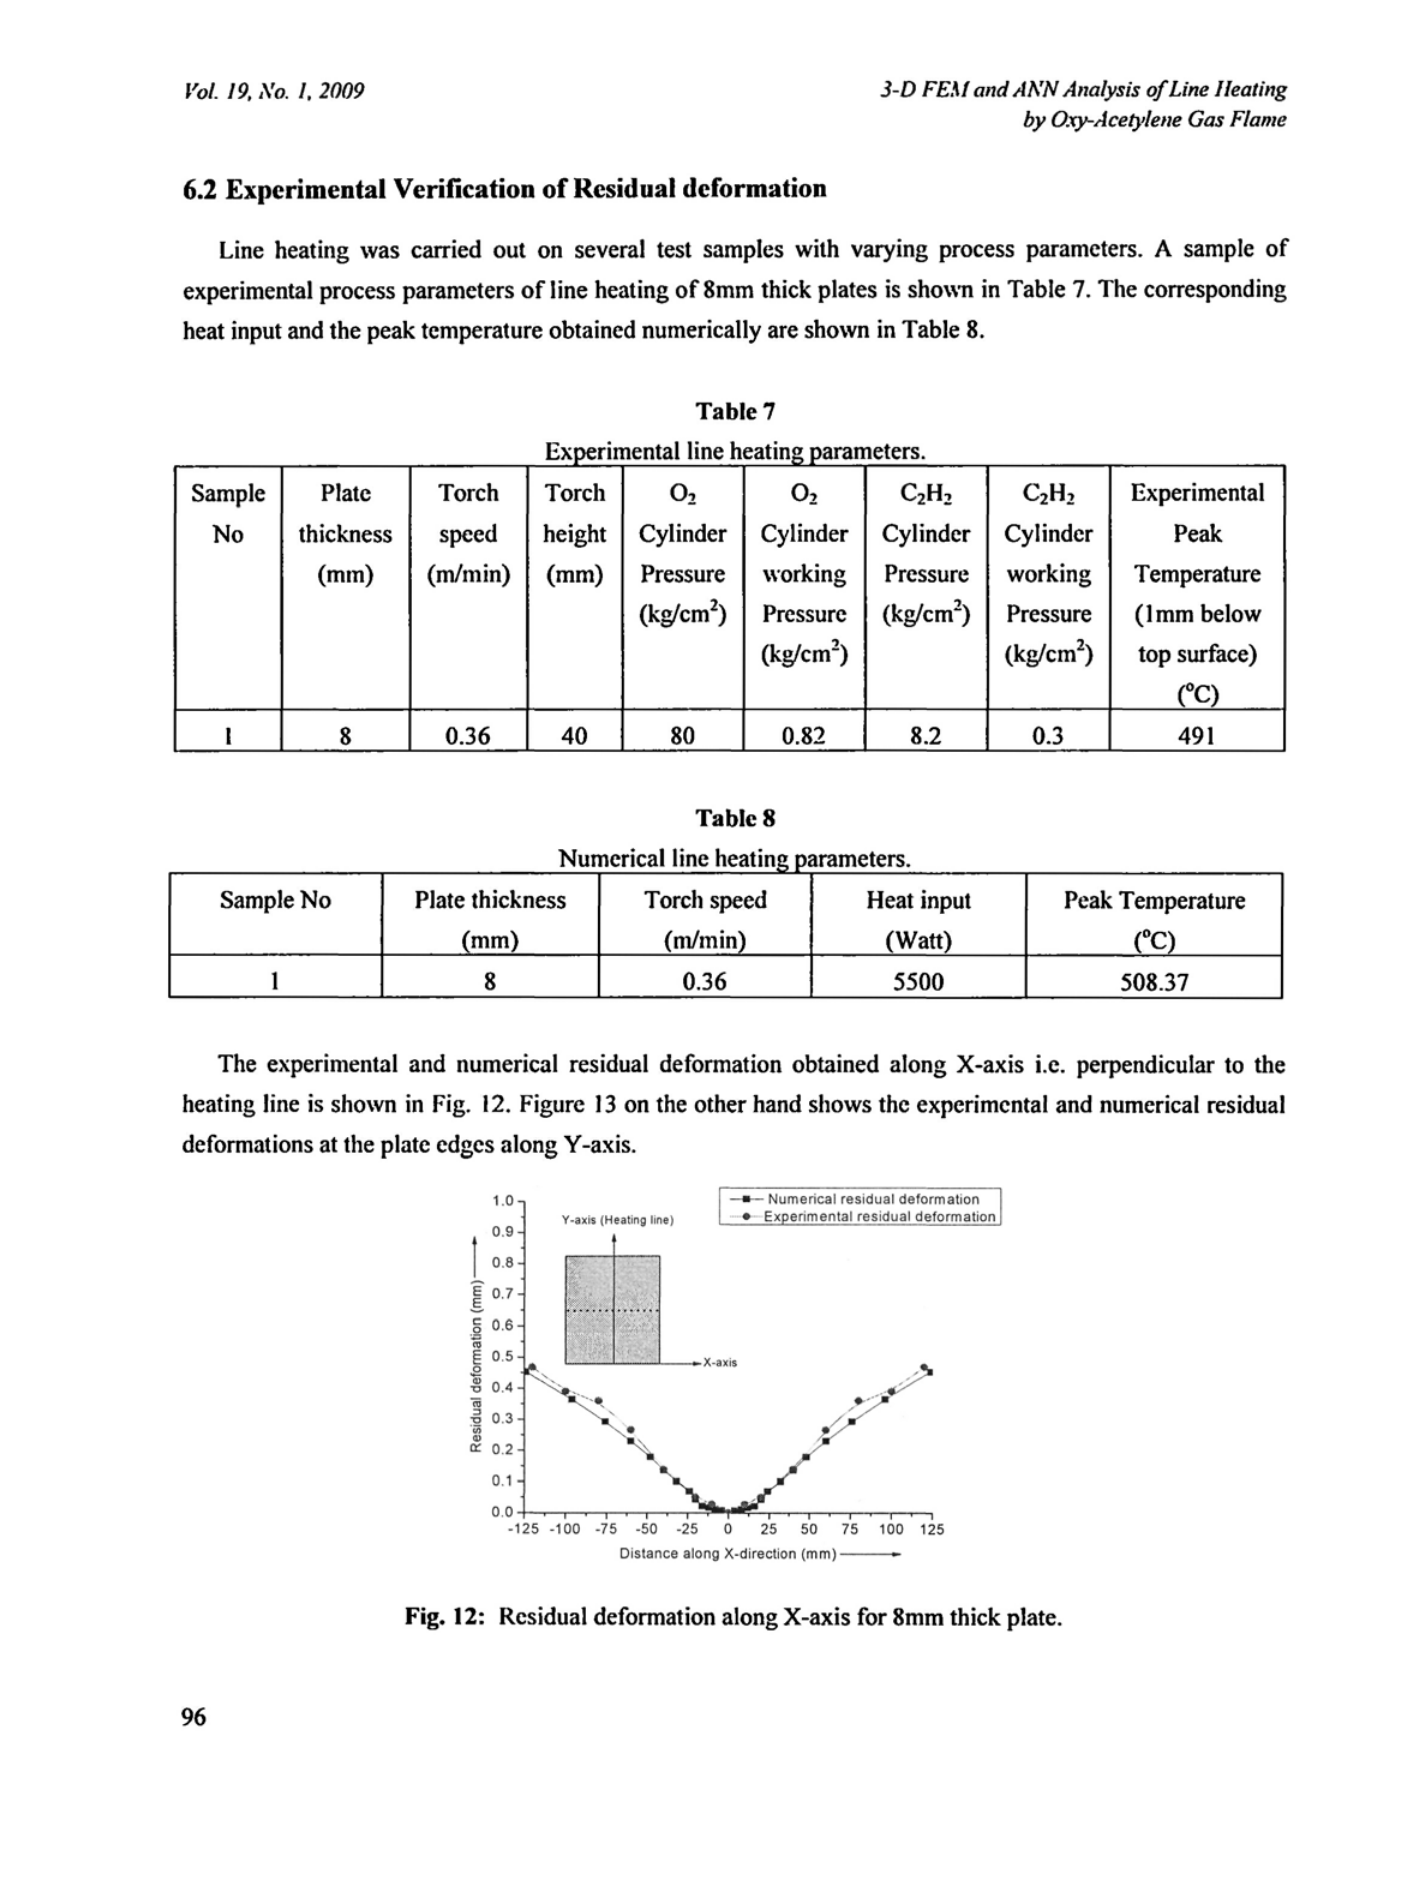
Fig. 12: Residual deformation along X-axis for 8mm thick